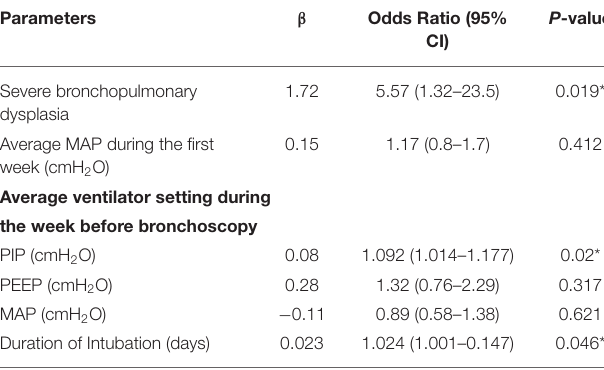
TABLE 2 | Multivariate logistic regression analysis to predict the development of